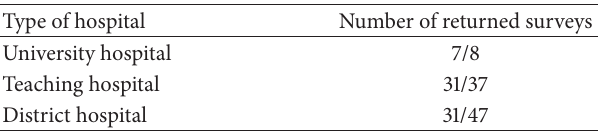
Table 1: Overview of survey respondents according to type of hospital in The Netherlands in 2010. Type of hospital Number of returned surveys University hospital 7/8 Teaching hospital 31/37 District hospital 31/47 Total number of respondents is 70; one survey was returned anonymously.